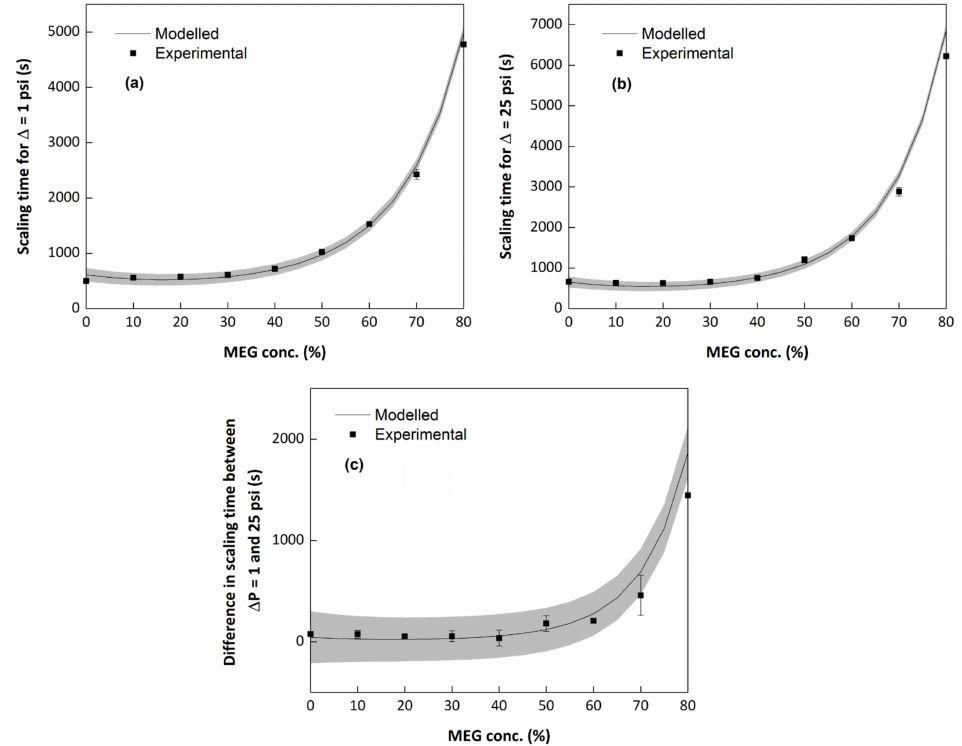
Figure 4. Modelled and experimental scaling time for different MEG concentrations in solution, where ( a ) scaling time to achieve ∆ P = 1 psi (initial scale formation); ( b ) scaling time to achieve ∆ P = 25 psi (advanced scale formation); and ( c ) difference between the scaling time to achieve ∆ P = 1 psi and ∆ P = 25